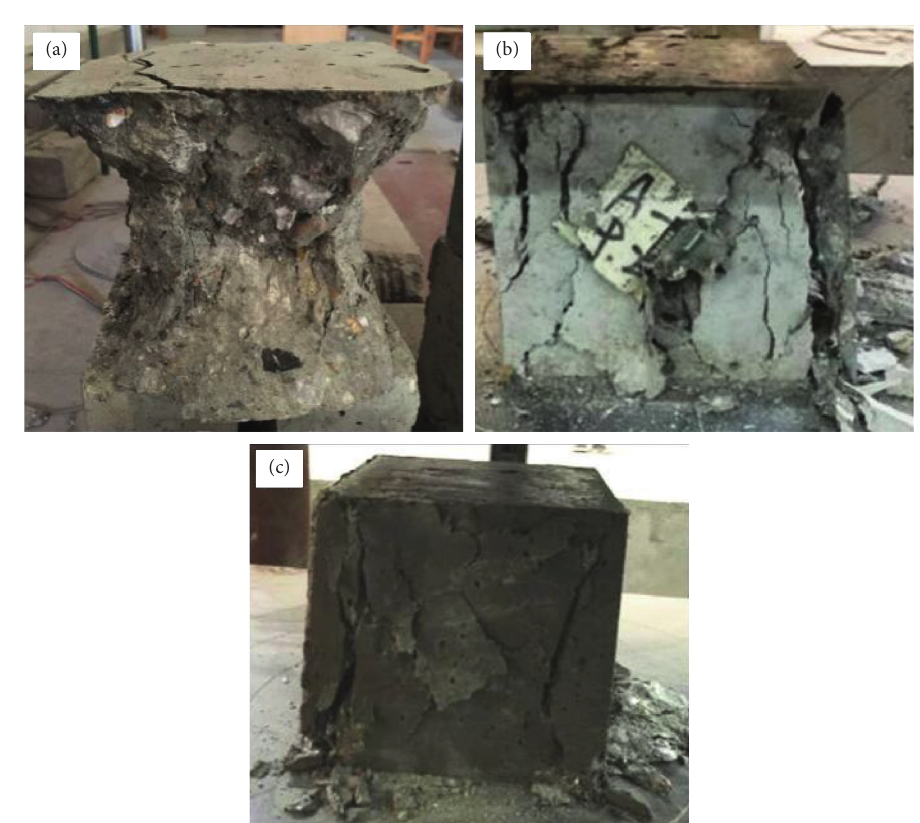
Figure 5: Block destroyed mode of cubic compression. (a) PC, (b) BFRC, and (c)